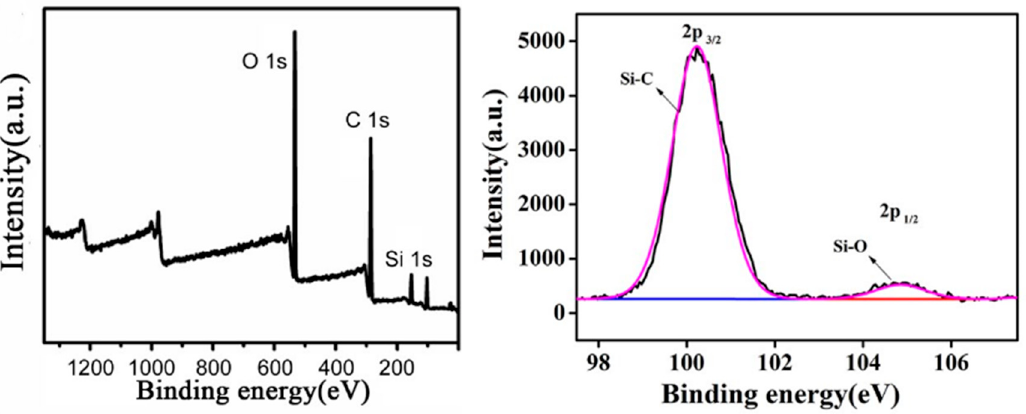
Figure 4. FT-IR ( left ) and Si NMR ( right ) spectra of EP-POSS.